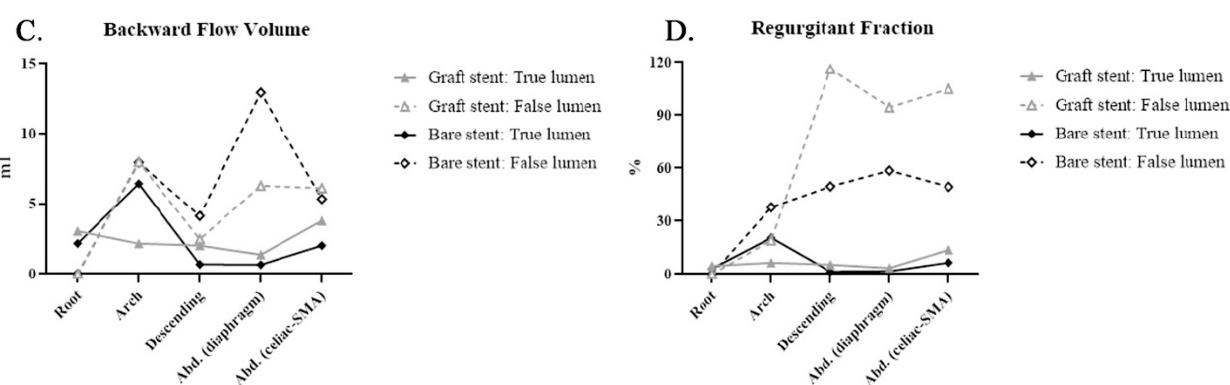
Figure 4. Covered (graft) stent and bare stent: Phase-contrast magnetic resonance imaging (PC-MRI) quantitative flow measurements after thoracic endovascular aortic repair (TEVAR) compared with those before TEVAR: ( A ) stroke volume (SV): SV exhibited a similar distribution between false and true lumens; ( B ) forward flow volume (FFV): FFV exhibited a similar distribution between false and true lumens; ( C ) backward flow volume (BFV): BFV in the false lumen was higher in patients with bare stents than in those with covered stents; ( D ) regurgitant fraction (RF): RF in the false lumen was higher in patients with graft stent than in those with bare stents.